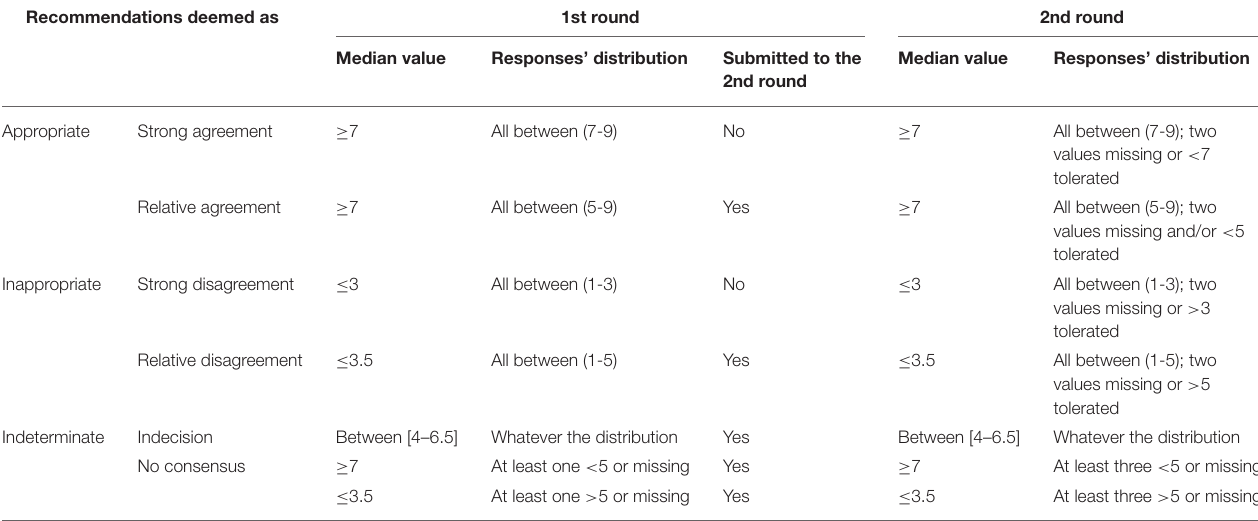
TABLE 3 | Rules to determine the strength of the consensus of the multidisciplinary experts. Recommendations deemed